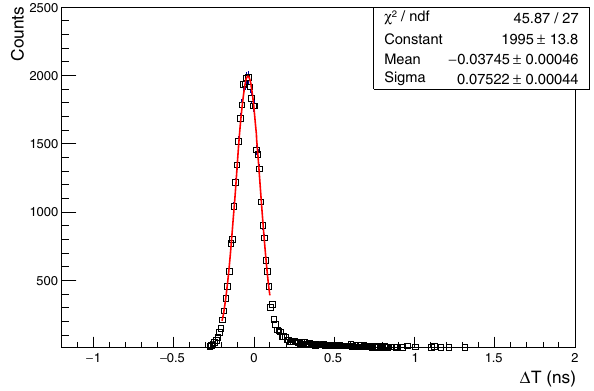
Fig. 15 Simulated distribution of T MRPC − Tr0 with pion beam. The beam momentum uncertainty and Tr0 timing jitter are